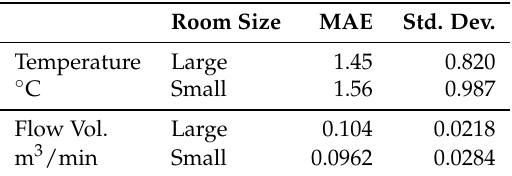
Table 4. Comparison between small and large rooms.